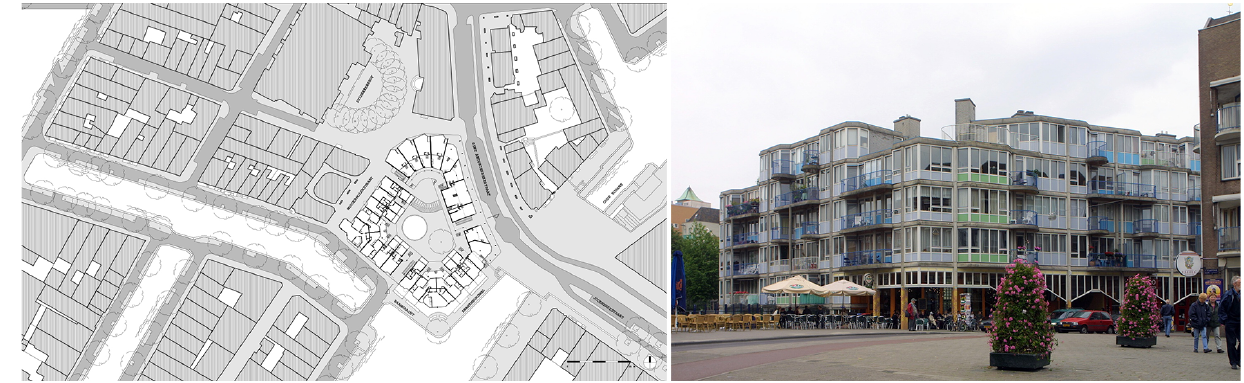
Figure 6. The Pentagon project in the Amsterdam Nieuwmarkt area, 1981. Top: Ground floor plan 1:500 by TEAM X and Aldo van Eyck. Bottom: Photograph of the Pentagon. Source: